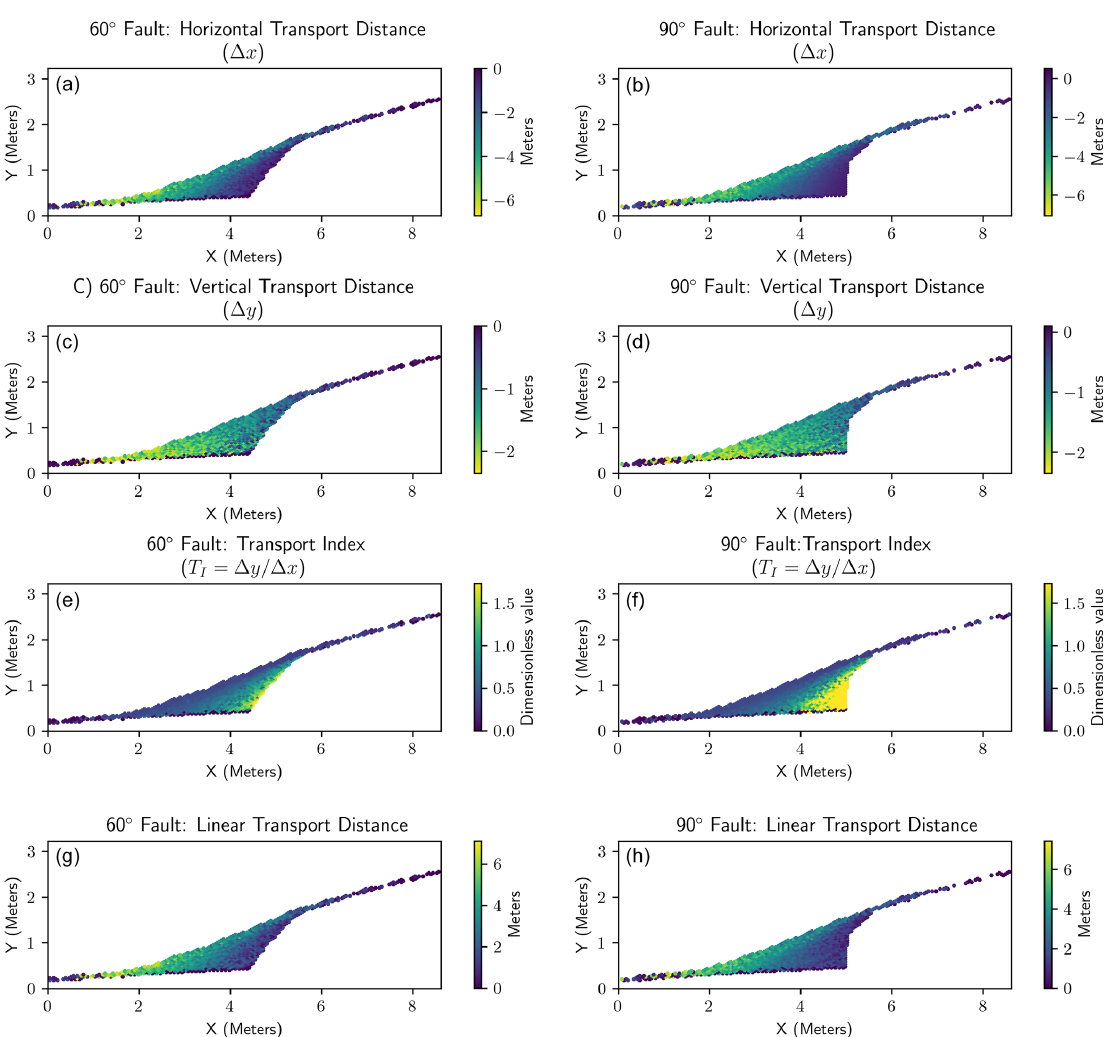
Figure 6. Representative illustration of the horizontal and vertical displacements of the mobile regolith cells from the sensitivity analysis. See the Supplement for plots from the full parameter space. (a, b) Total horizontal displacement defined as the change in x position of a cell from the earthquake event until the end of the model run for the 60 ◦ fault (a) and the vertical fault (b) . (c, d) Equivalent plots for the total change in the vertical y position. (e, f) Plots of the ratio (the transport index) between the total vertical movement and total horizontal movement. (g, h) Plots of the linear distance from the mobile regolith cell’s original position at the start of the model run (linear distance: (cid:112) (cid:49)x 2 + (cid:49)y 2